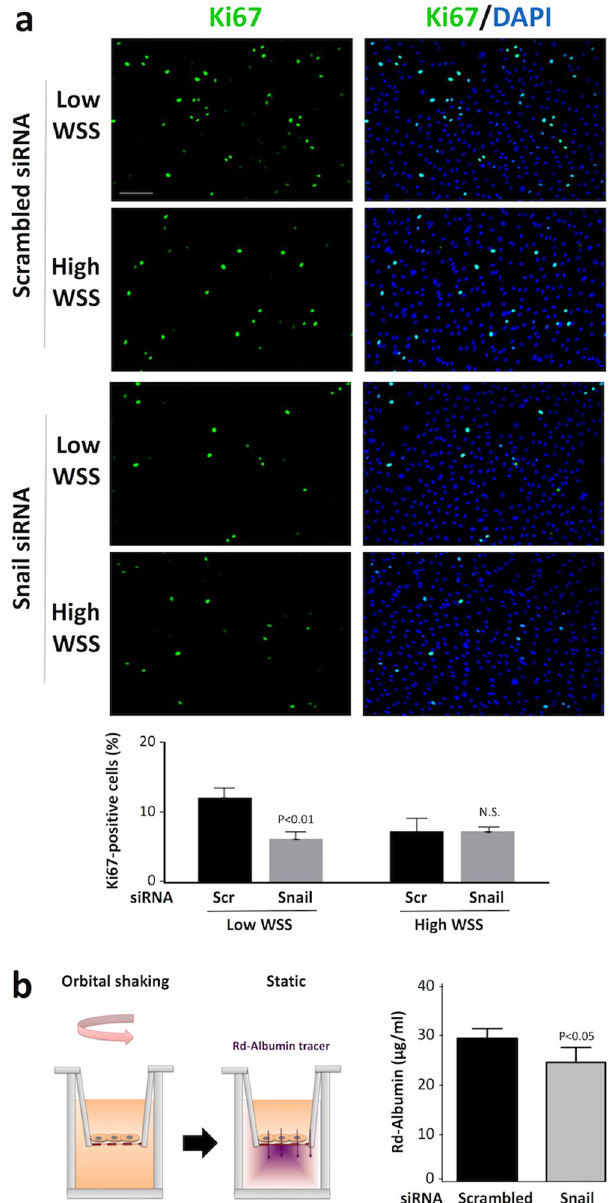
Figure 3. Snail enhanced proliferation and permeability in EC exposed to low shear stress. HUVEC were treated with siRNA targeting Snail or with scrambled (Scr) non-targeting siRNA. ( a ) Cells were subsequently cultured in 6 well plates prior to exposure to orbital flow to generate low or high wall shear stress (WSS) for 72 h. Cell proliferation was quantified by immunofluorescent staining using anti-Ki67 antibodies and co- staining using DAPI. Representative images are shown (Scale bar, 50 μ m). The % Ki67-positive cells were calculated for multiple fields of view in four independent experiments using cells from different donors and mean levels + / − SEM are shown. Differences between means were assessed using a 2-way ANOVA. ( b ) Cells cultured on Transwell inserts were exposed to orbital flow (low WSS) for 72 h prior to assessment of endothelial permeability under static conditions using rhodamine (Rd)-albumin as a tracer. A schematic is shown (left panel). The concentration of Rd-albumin in the lower compartment was measured. Data were pooled from four independent experiments using cells from different donors and mean values + / − SEM are shown (right panel). Differences between means were assessed using an unpaired